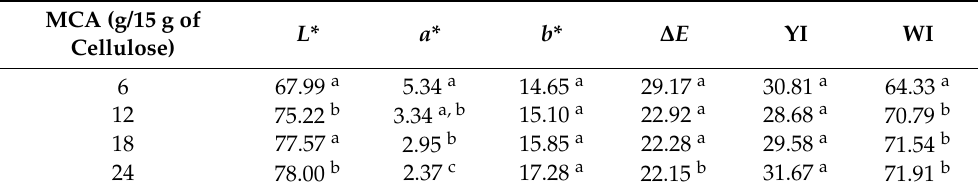
Table 1. Color values of bacterial cellulose from nata de coco and CMC n synthesized with various amounts of